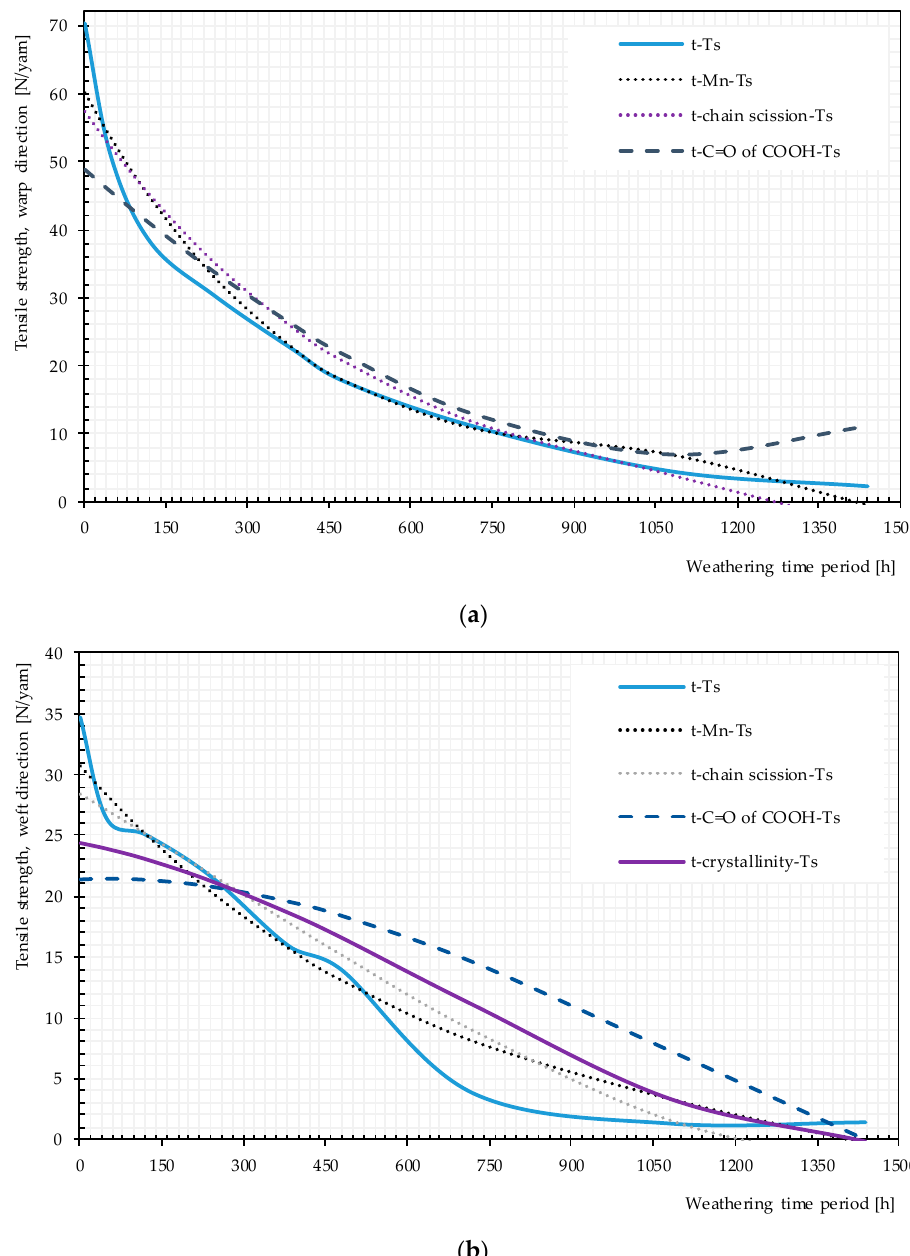
Figure 20. Direct and multistep pathway diagrams for the tensile strength deterioration of uncoated PET Type II under artificial exposure Method M4: ( a ) warp direction; and ( b ) weft direction. t, time of exposure (hour); Ts, tensile strength